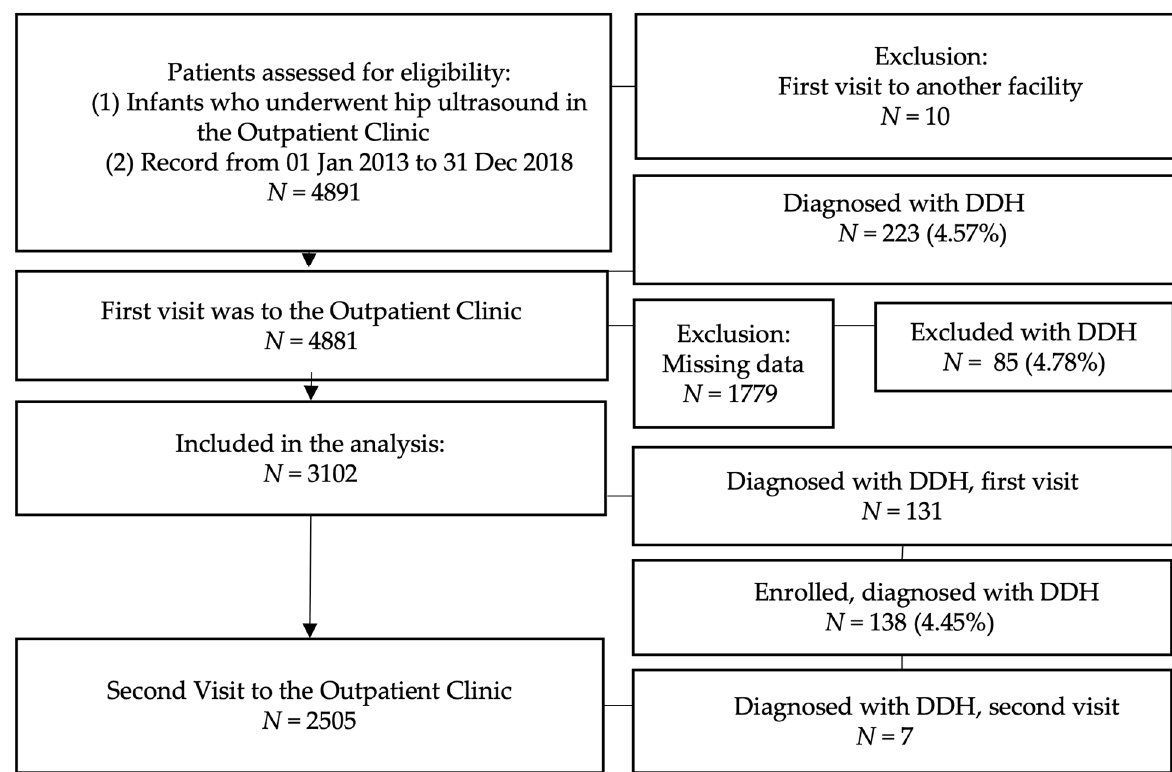
Figure 1. The flow chart of included and excluded patients and reasons for exclusions.